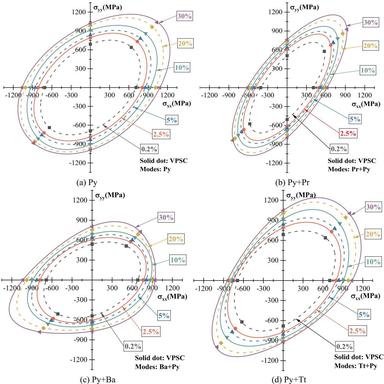
Evolution of yield loci for the α-Ti tube with different combinations of deformation mechanisms in the thought experiment. The activation of Tt or Ct or Ba slip promotes the irregular evolution of yield loci, while the activation of Pr or Py reduces it.